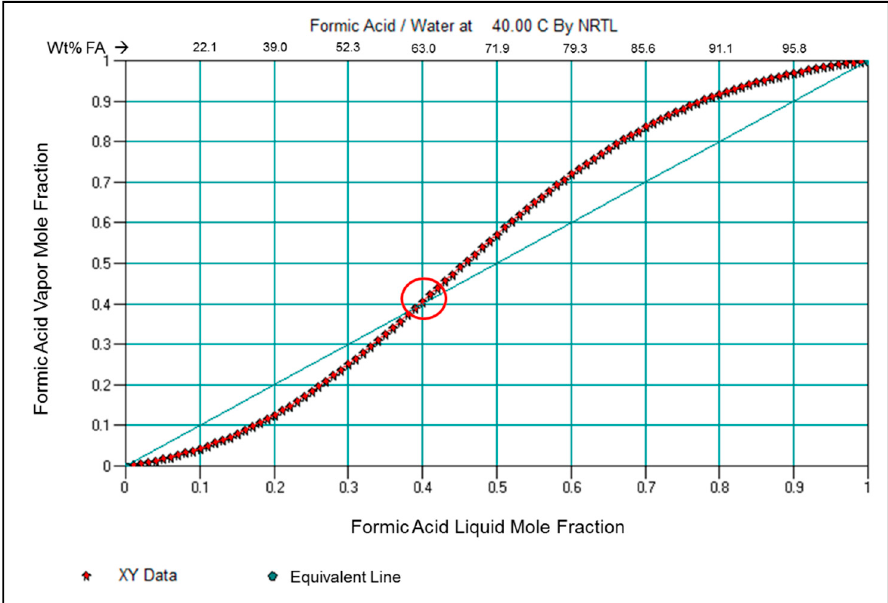
Figure 10. FA-water vapor Txy constant temperature equilibrium plot at a constant temperature of 40 °C generated using ChemCad-generated NRTL simulation data. The red circle shows the azeotropic composition at those conditions.